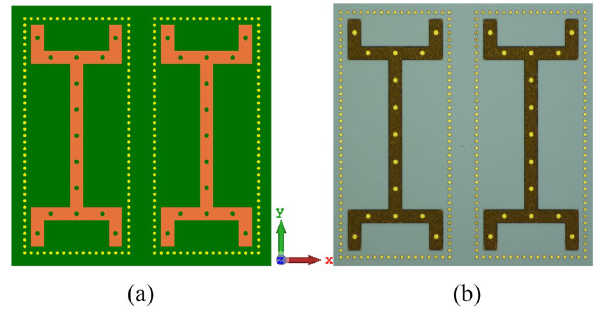
Figure 5. Configuration of the proposed SIW-MTS inspired AoC, ( a ) layout, and ( b ) fabricated GaAs